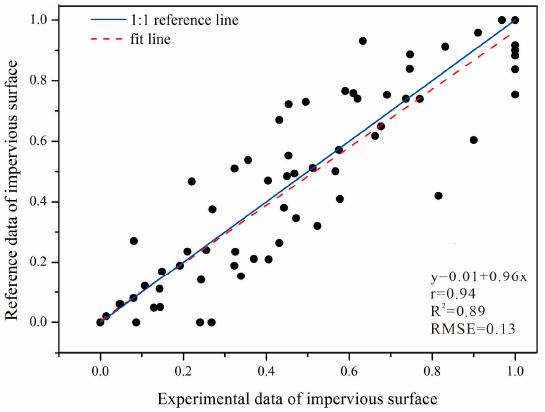
Figure 4. The proportion of each endmember in the image of validation points.